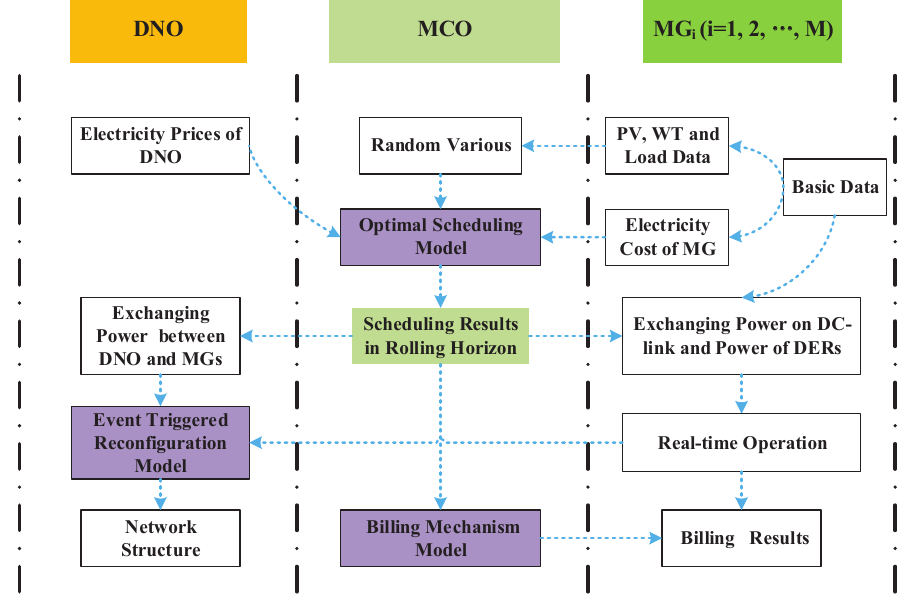
Figure 1. Schematic diagram of interactions between different